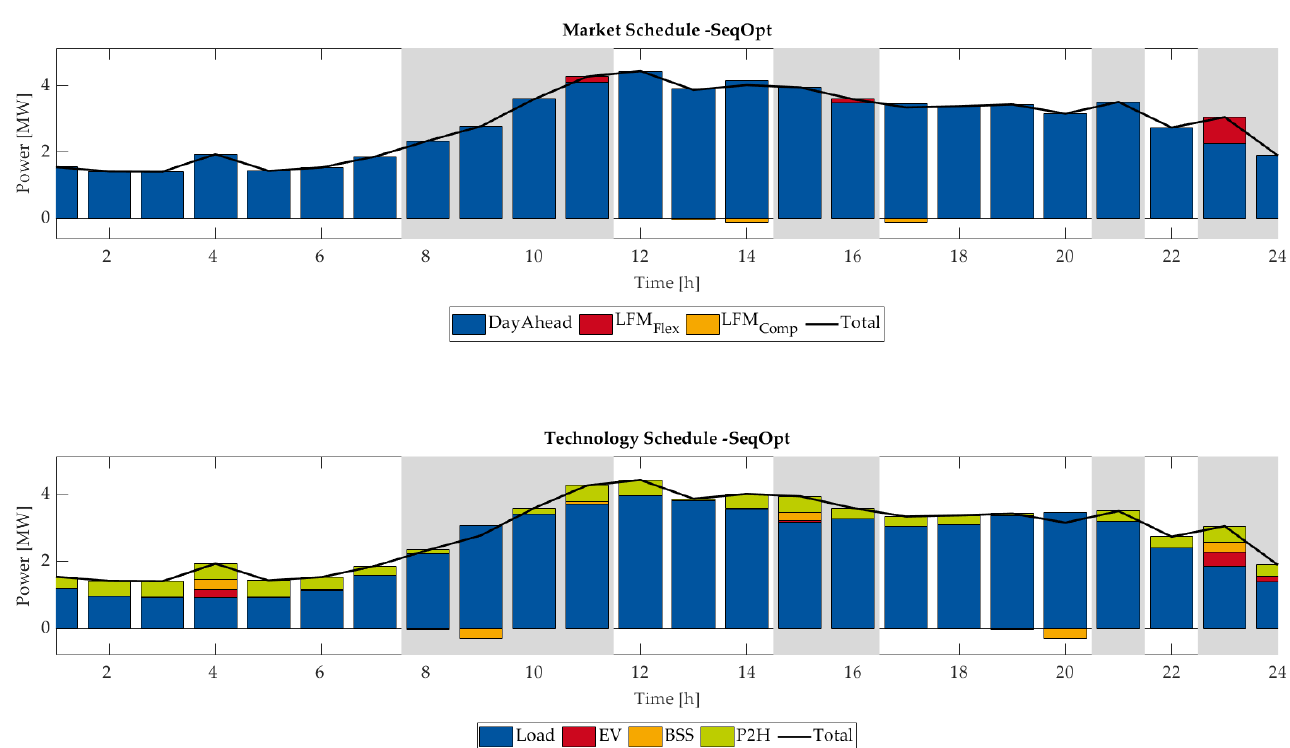
Figure 14. Schedules of operational planning SeqOopt of EMS at node 3 (Congestion times shaded in grey).